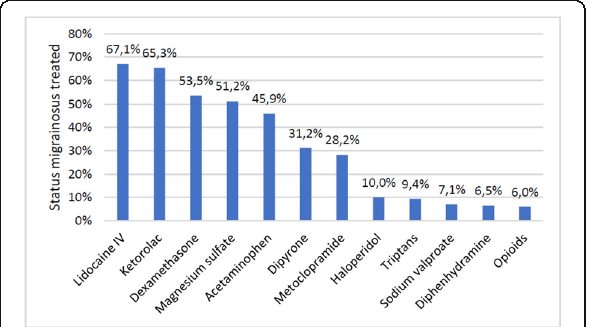
Fig. 1 (abstract P38). See text for description.